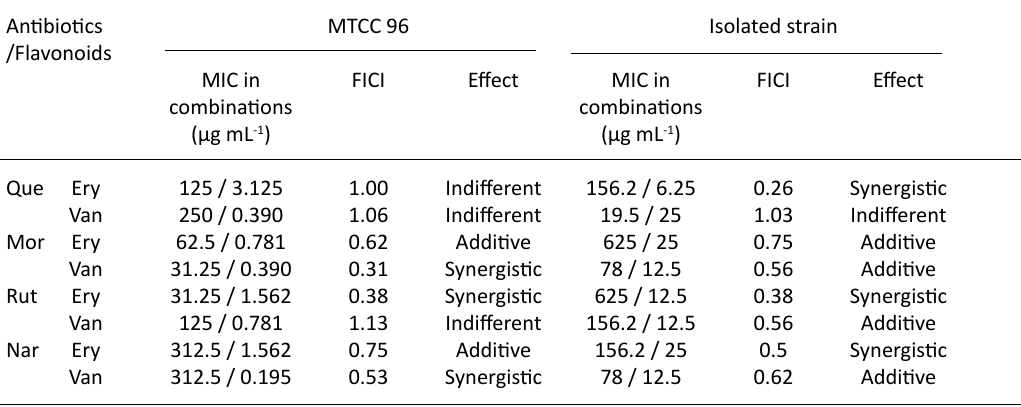
Table 2. Combinatory inhibitory effects of flavonoids with antibiotics against Staphylococcus aureus Antibiotics MTCC 96 Isolated strain /Flavonoids MIC in FICI